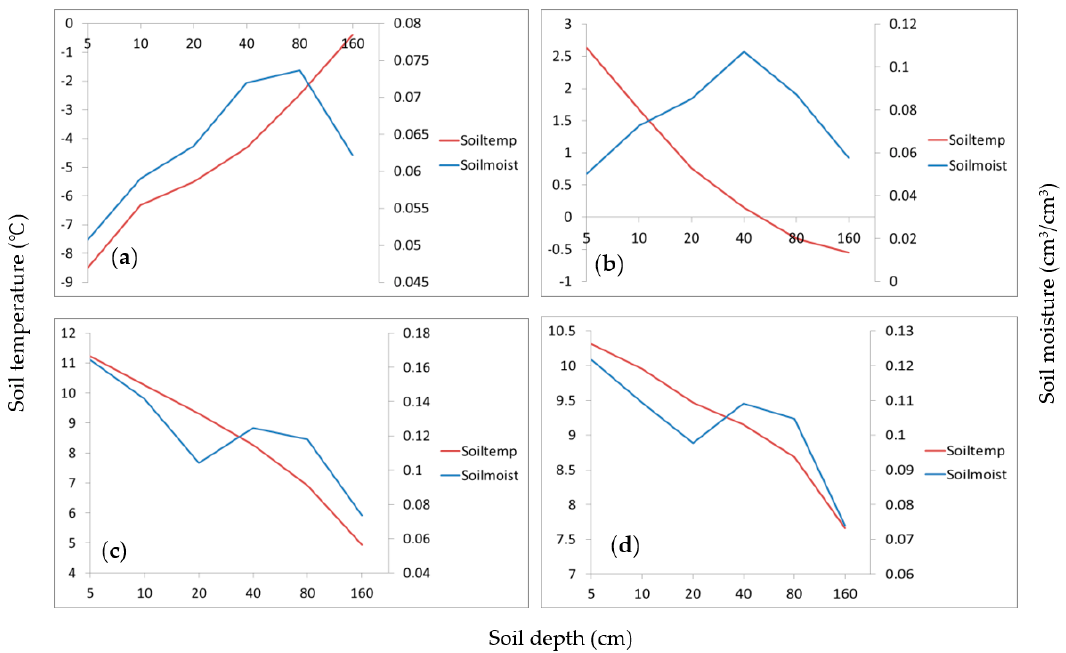
Figure 8. Same as Figure 7, but for the Lhari station: ( a ) winter, ( b ) spring, ( c ) summer and ( d ) au- tumn.